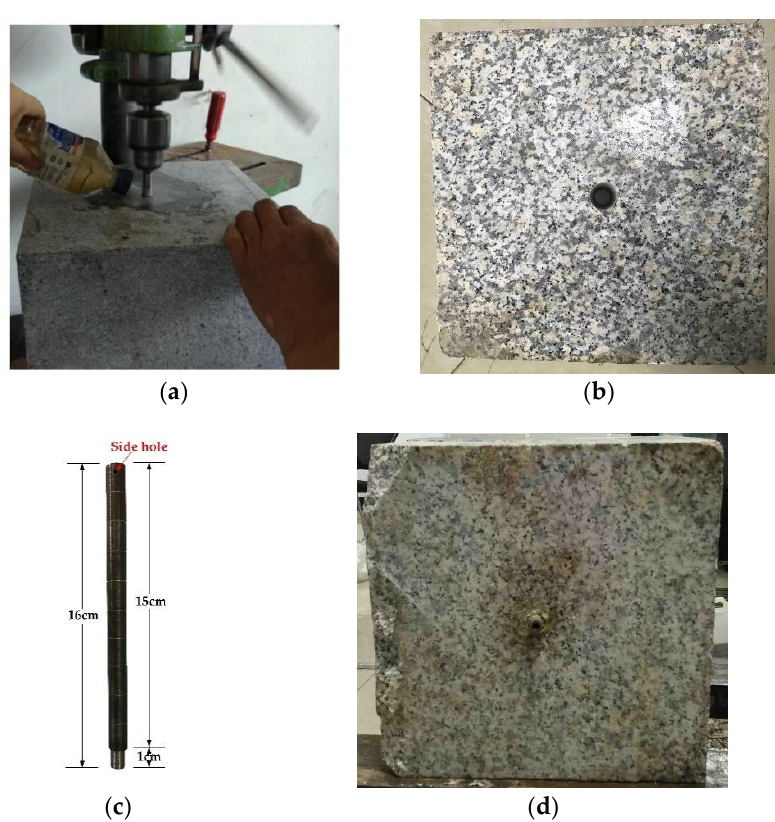
Figure 3. Rock sample preparation: ( a ) Drilling the borehole; ( b ) a rock sample after drilling the borehole; ( c ) the water injection tube; and ( d ) a prepared rock sample.